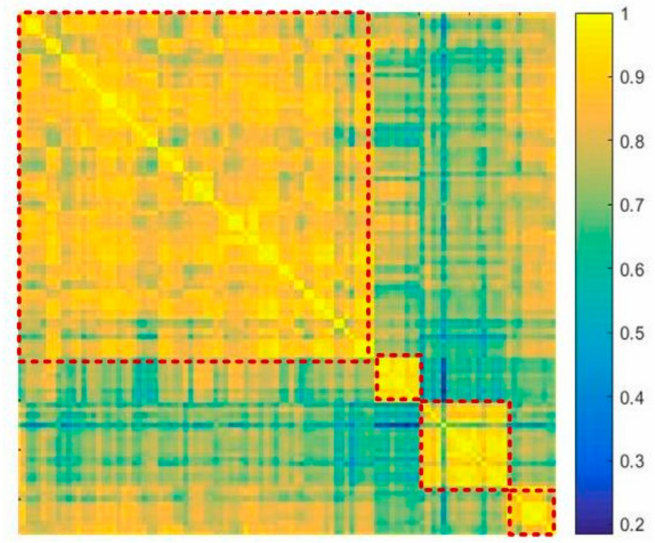
Figure 5. Similarity relationship of parameters in multiple